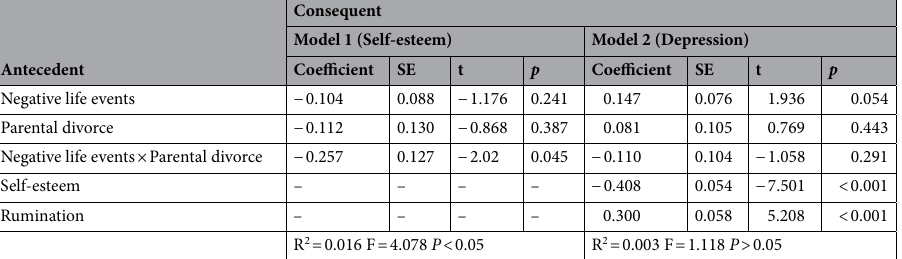
Table 3. Model coefficients for the conditional process model.